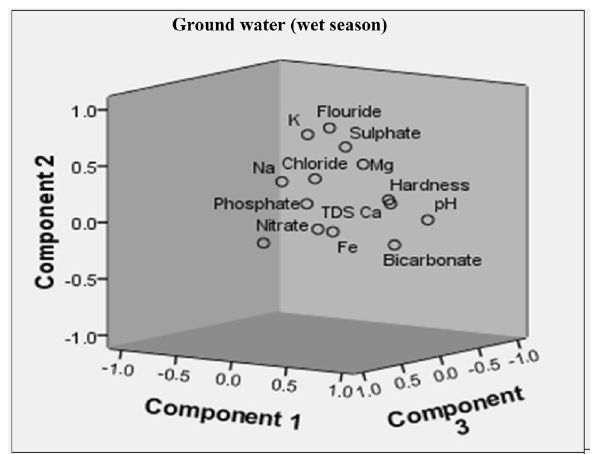
Fig. 3 Principal component analysis (PCA) for the selected aquifers in the wet season